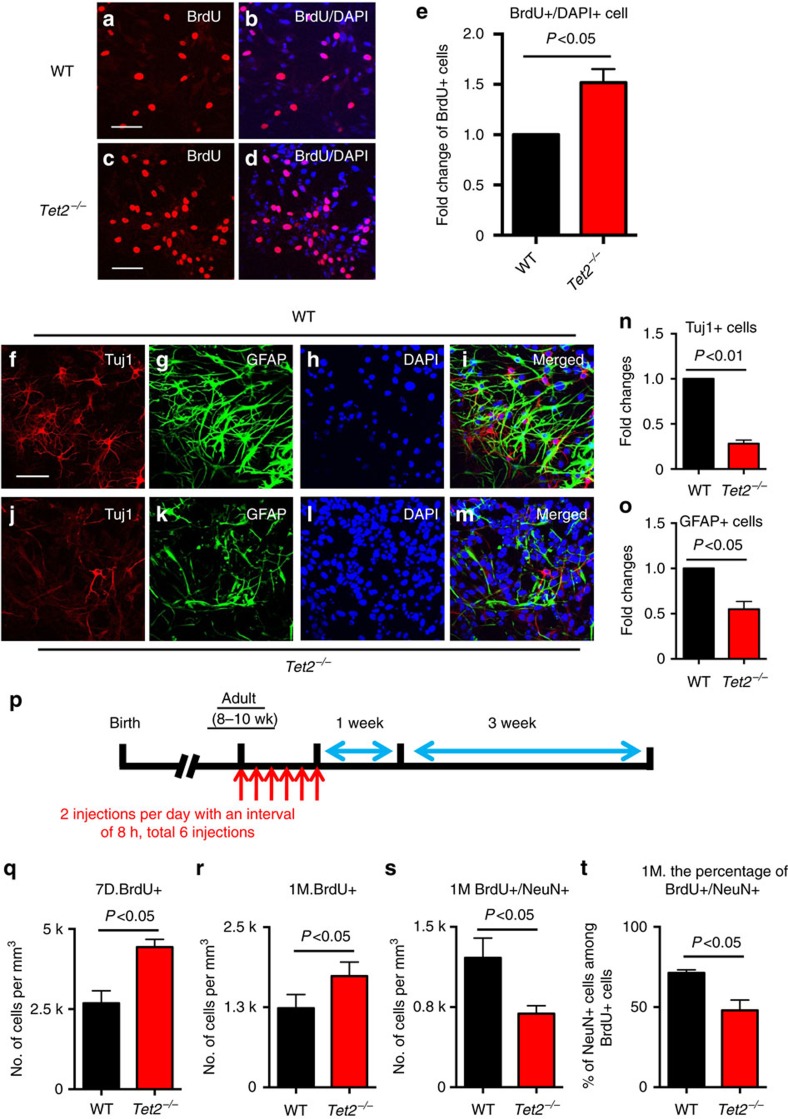
Tet2 regulates the balance of aNSC proliferation and differentiation both in vitro and in vivo.(a–d) Representative BrdU staining in both WT (a) and Tet2−/− (c) aNSCs to access their proliferation states. Tet2 depletion promoted aNSC proliferation. (b,d) Overlay between BrdU and DAPI staining. Scale bar, 50 μm. n=3. (e) Quantification of BrdU+ aNSCs from WT and Tet2−/− mice in a–d indicated that depletion of Tet2 significantly promoted aNSC proliferation (n=3; unpaired t-test, P<0.05). (f–m) Representative IF staining in WT and Tet2−/− differentiated neural cells from isolated in vivo aNSCs with neuronal cell marker Tuj1 (f,j) and glial marker GFAP (g,k). The loss of Tet2 leads to a decrease of Tuj1+ neurons and GFAP+ glial cells. DAPI staining (h,l) and merged overlay (i,m) are indicated. Scale bar, 50 μm. n=4. (n,o) Quantification of Tuj1+ cells (n) and GFAP+ glial cells (o) in WT and Tet2−/− neural cells differentiated from aNSCs (n=4; unpaired t-test, P<0.01 or 0.05). Fewer Tuj1+ neuronal cells and GFAP+ glial cells were found Tet2−/−. (p) A diagram shows the experimental scheme to investigate adult neurogenesis in WT and Tet2−/− mice in vivo. WT and Tet2−/− mice were administered BrdU and killed at 1 or 4 weeks afterwards to assess the aNSC proliferation and differentiation states in the presence or absence of Tet2. (q) Quantification of BrdU+ cells in the hippocampus of WT and Tet2−/− mice killed 7 days after final BrdU administration. Depletion of Tet2 resulted in a significant increase of aNSC proliferation (WT, n=4; Tet2−/−, n=3; unpaired t-test, P<0.05). (r) Quantification of BrdU+ cells in the hippocampus of WT and Tet2−/− mice 4 weeks after the final BrdU administration. Depletion of Tet2 resulted in a significant increase of aNSC proliferation (n=5; unpaired t-test, P<0.05). (s) Quantification of BrdU+/NeuN+ cells in the hippocampus of WT and Tet2−/− mice 4 weeks after the final BrdU administration (n=4; unpaired t-test, *P<0.05). (t) Quantification of the percentage of BrdU+/NeuN+ cells among total BrdU+ cells in the hippocampus of WT and Tet2−/− mice 4 weeks after the final BrdU administration (n=4,; unpaired t-test, *P<0.05).